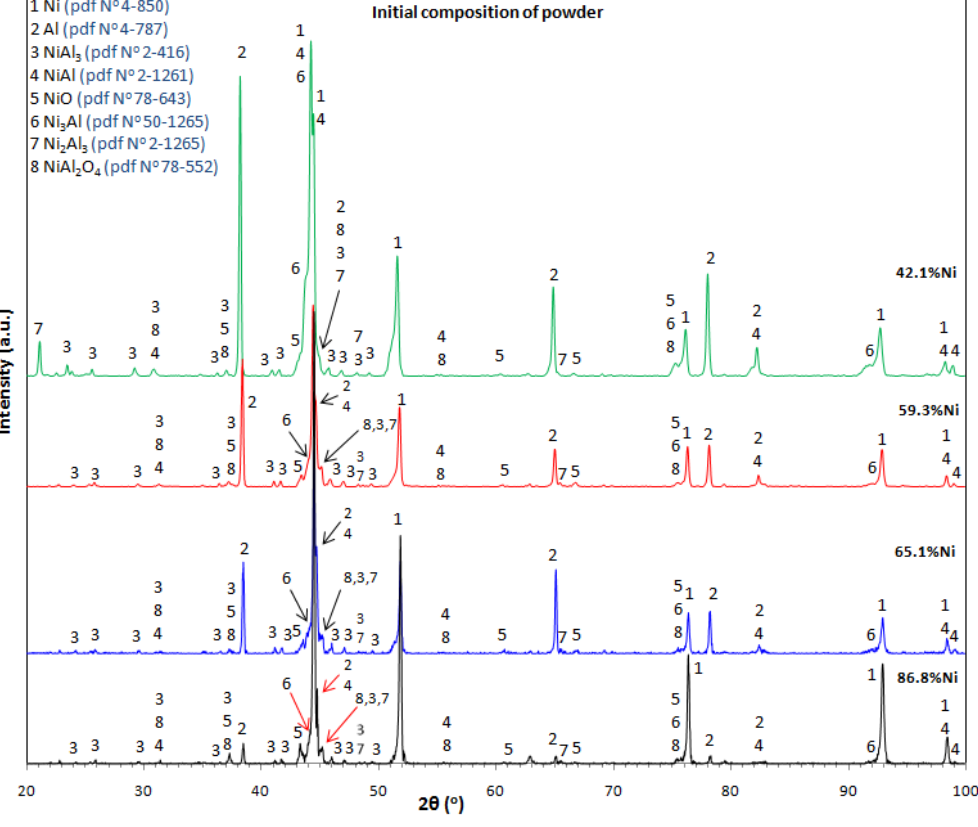
Figure 2. X ‐ ray diffraction (XRD) of CAFSY coatings for different Ni + Al starting mixtures after two gun passes.